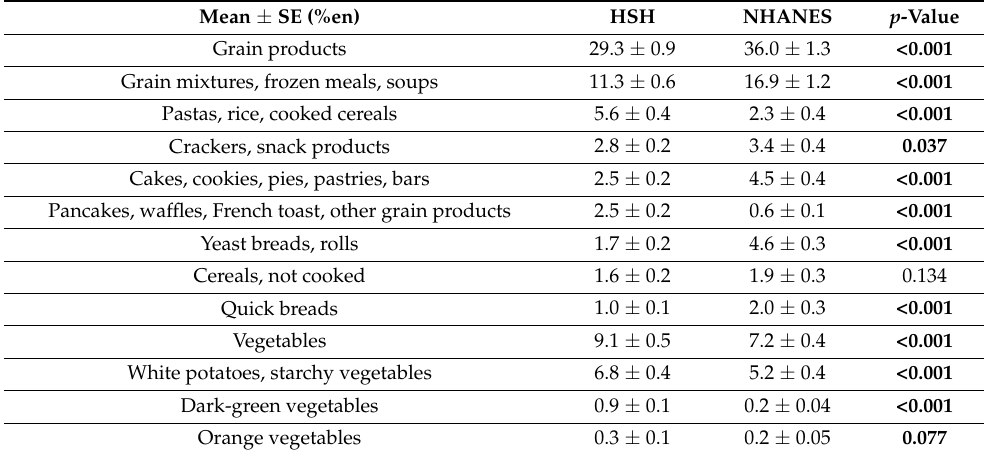
Table 3. Percent energy from major and sub-major food groups in HSH and